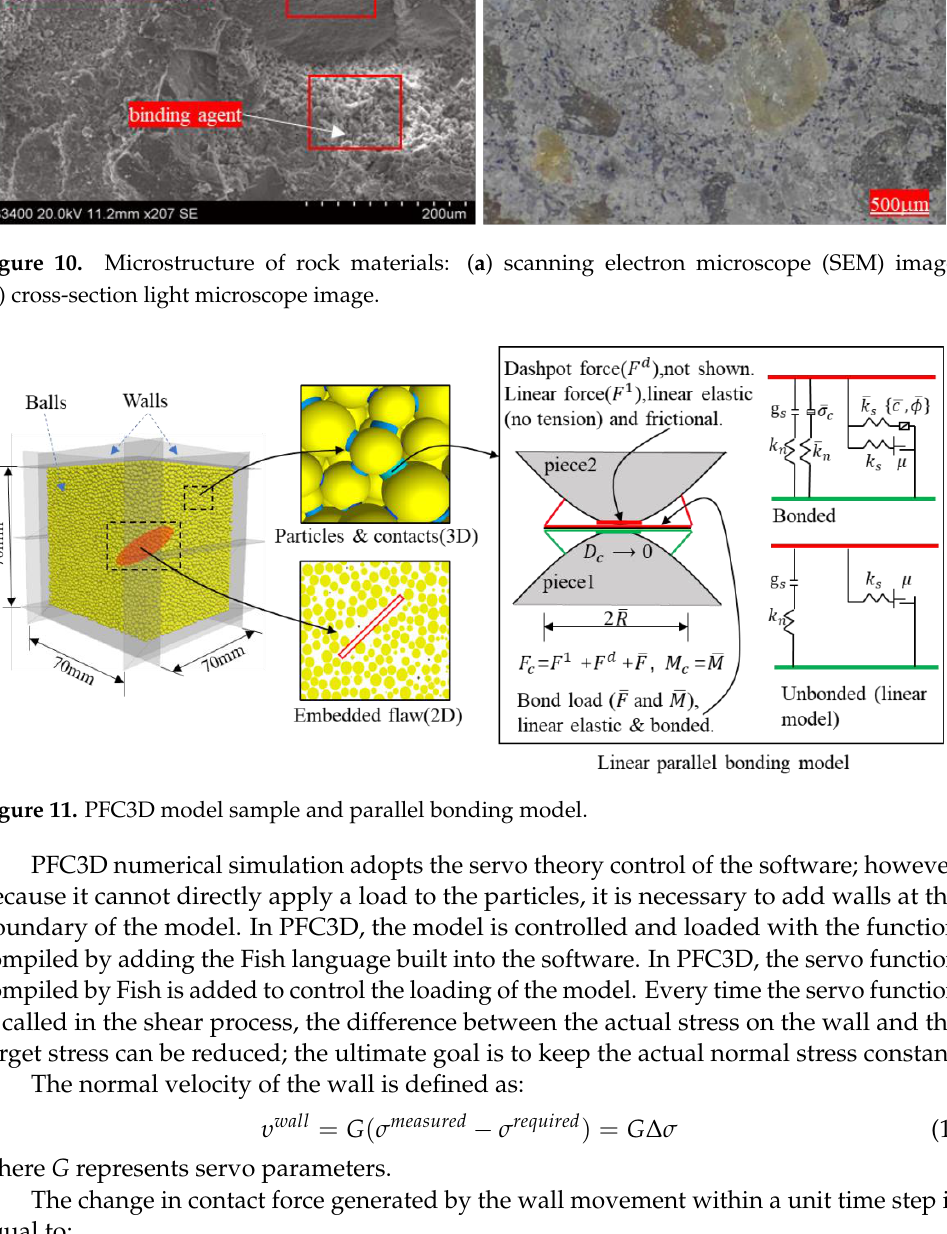
Figure 10. Microstructure of rock materials: ( a ) scanning electron microscope (SEM) image; ( b ) cross-section light microscope image.